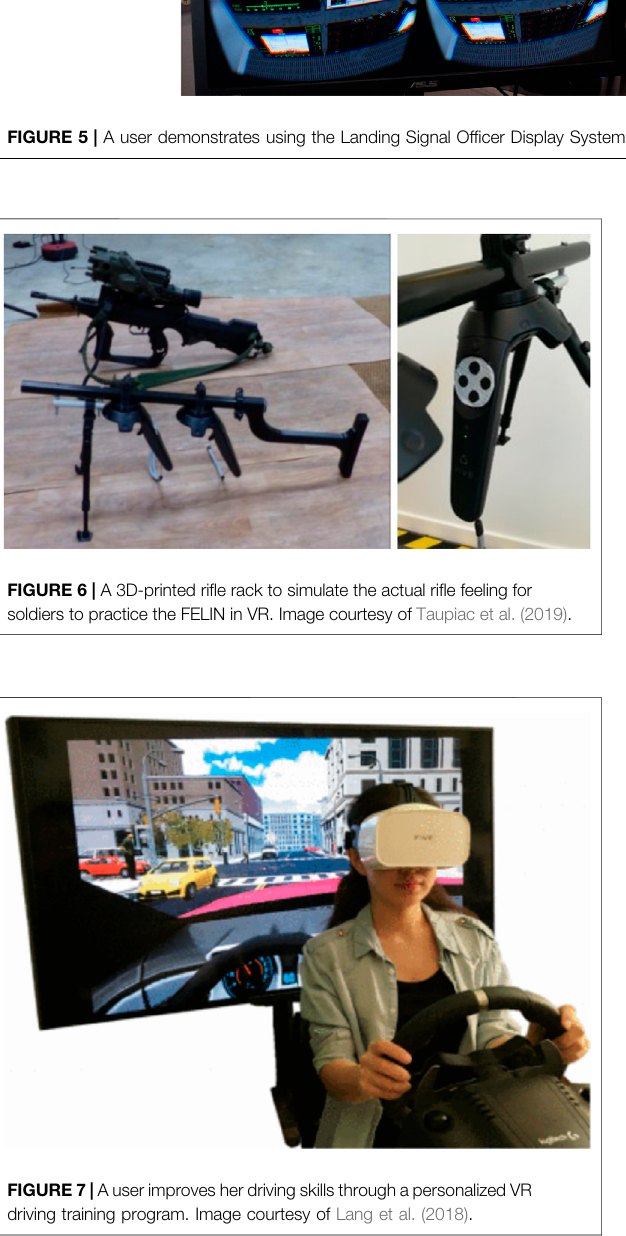
Frontiers in Virtual Reality |